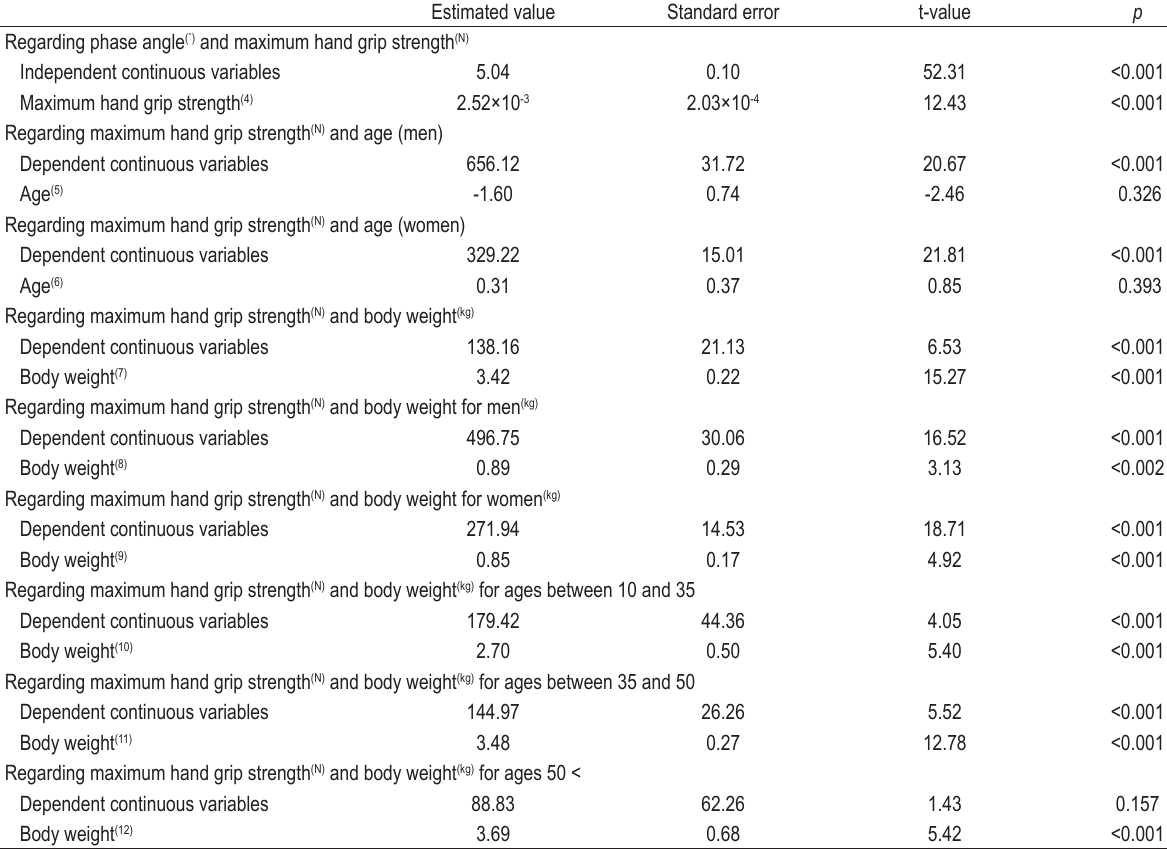
TABLE 2. Results of linear regression correlation of phase angle, maximum hand grip strength, body weight, and age (n=708)